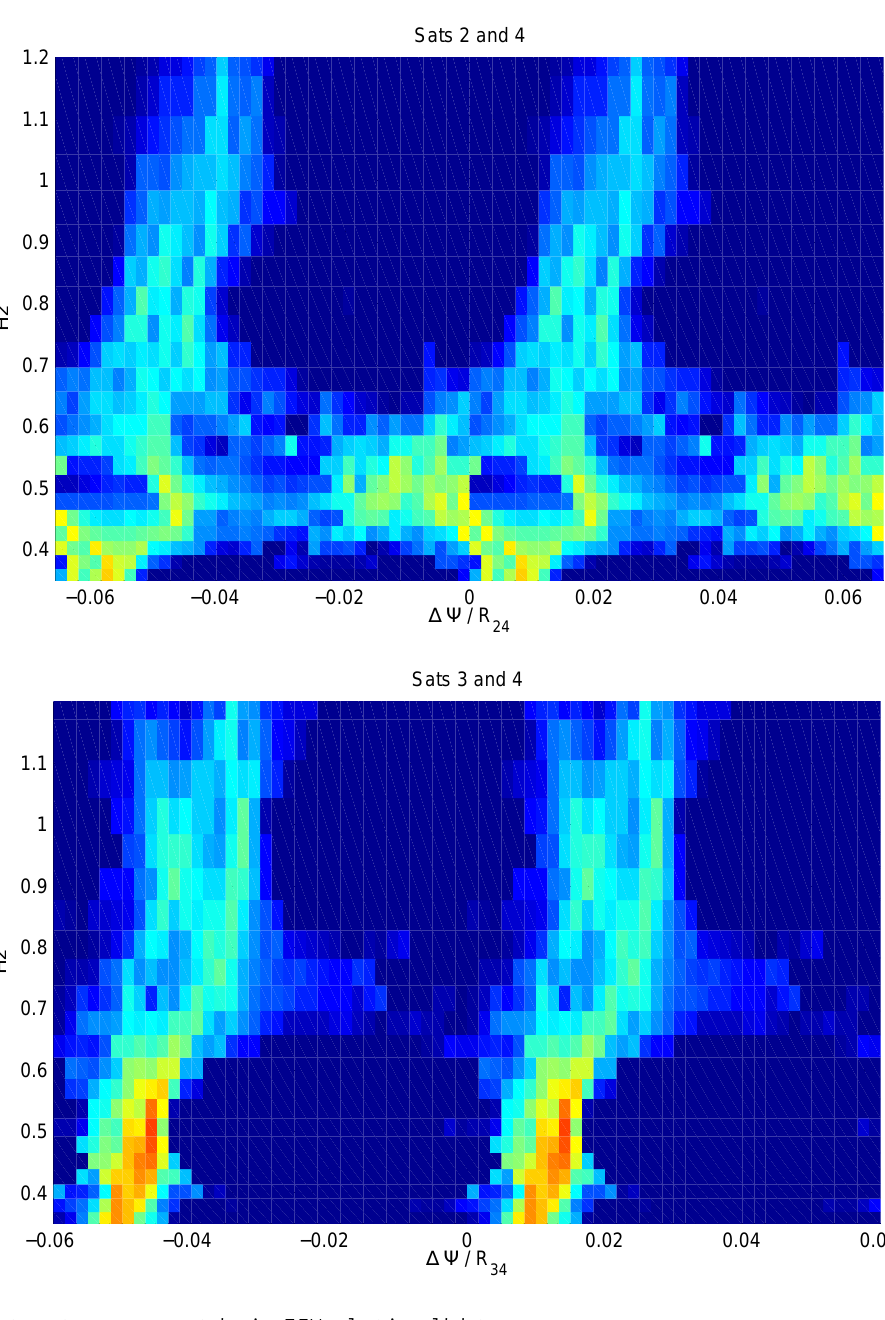
Fig. 4. The ω − k joint spectrogram computed using EFW electric field data.